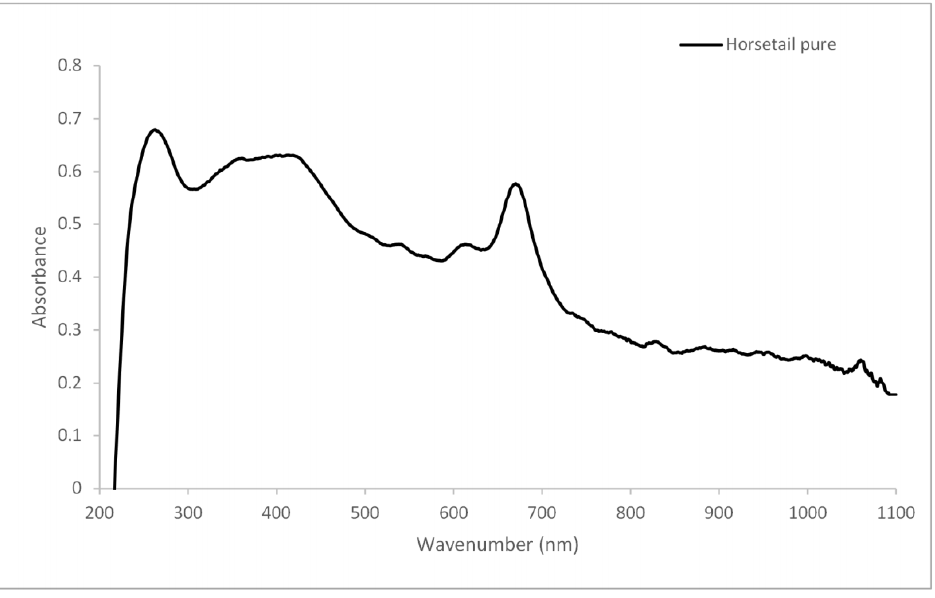
Figure 1. The UV-VIS spectrum of horsetail.